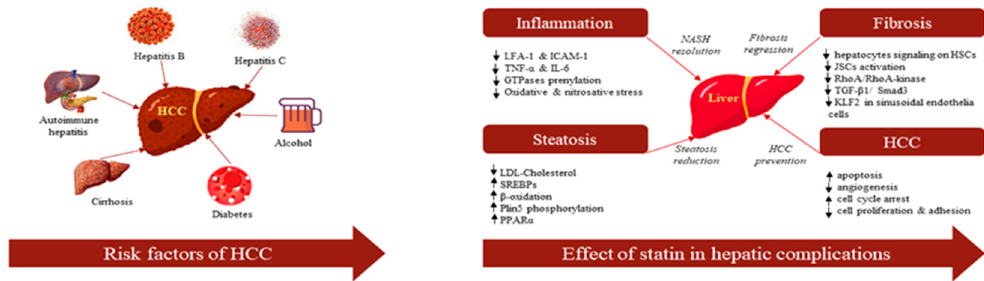
Figure 1. Risk factors of hepatocellular carcinoma (HCC) and the e ff ect of statins in hepatic